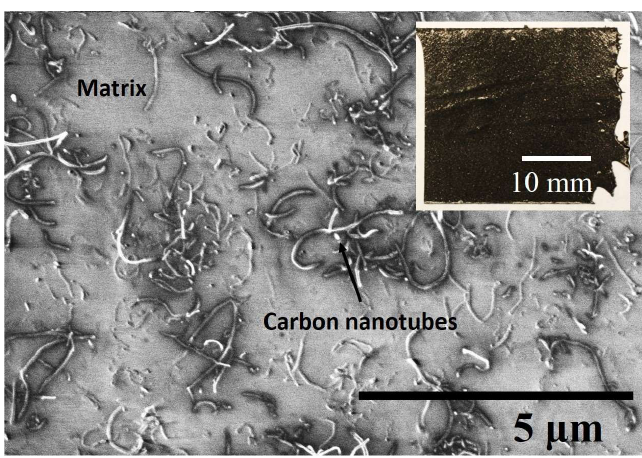
Figure 2. Scanning electron microscope (SEM) image of CNT distribution in the matrix.